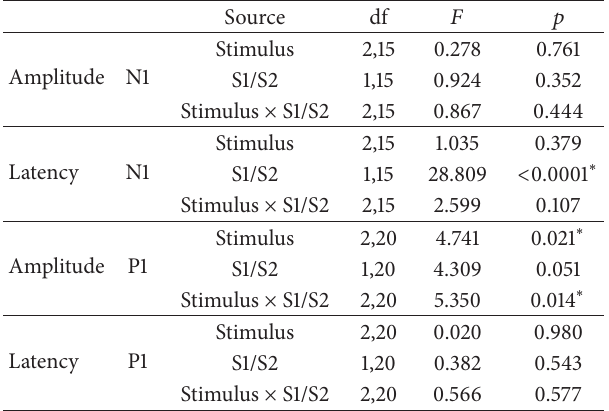
Table 5: Infants: comparisons of amplitude and latencies for the N1 and P1 components of the slow cortical response to S1 versus S2 elicited by /dada/, /daba/, and /daDa/ using two-way mixed-model measures analyses of